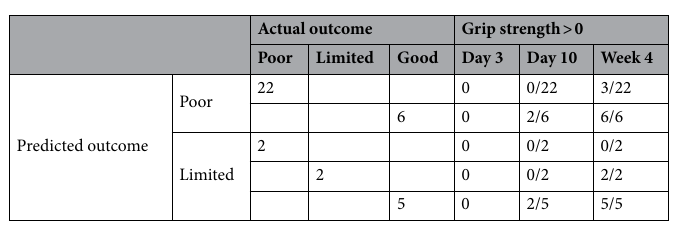
Actual outcome Grip strength >